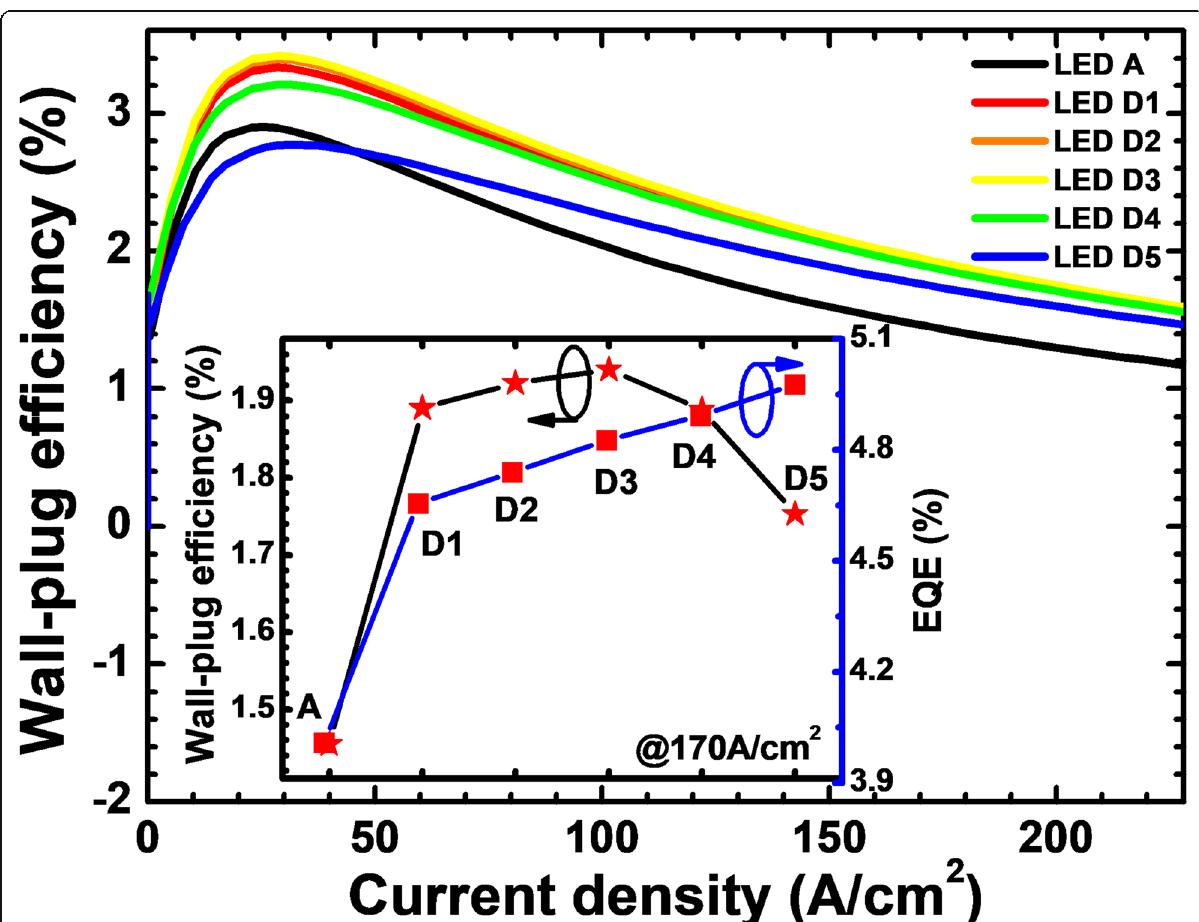
Fig. 11 Relationship between WPE and the injection current for LEDs A and D i ( i = 1, 2, 3, 4, and 5). Inset: the EQE and WPE for the investigated LEDs structured with a p-AlGaN layer with various doping concentrations when the current density is 170 A/cm 2